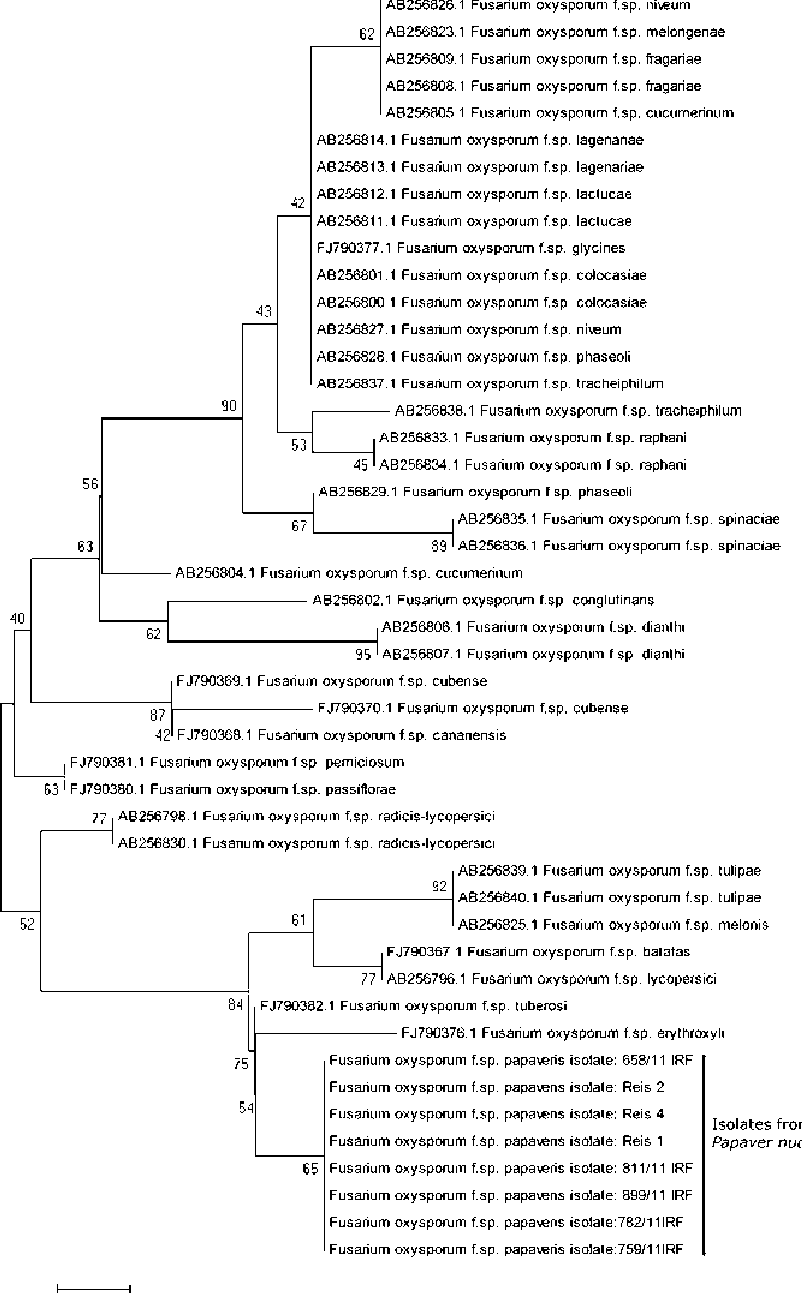
Figure 5. Phylogenetic tree based on Pgx4 gene sequences built by Mega5 software with Neighbor joining method; boot- strap values from 1000 replicates are shown at the